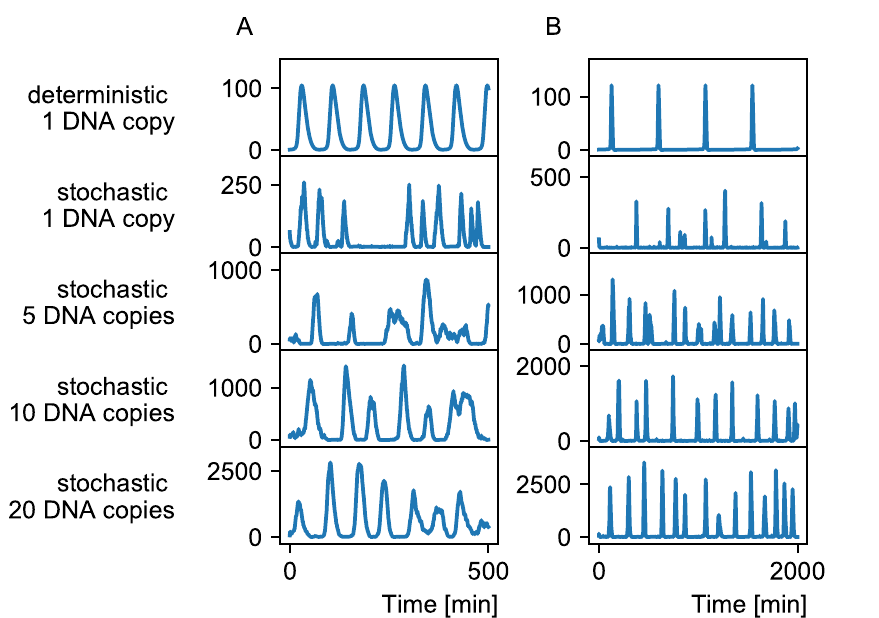
Fig 8. Stochastic time series. Time series of two examples of Ss-LrpB compatible systems are shown (A and B), in a deterministic and stochastic models from 1 to 20 DNA copy numbers. The oscillations become more regular for higher copy numbers. Note that the frequency is higher in the stochastic models with respect to the deterministic model for the example on the right.